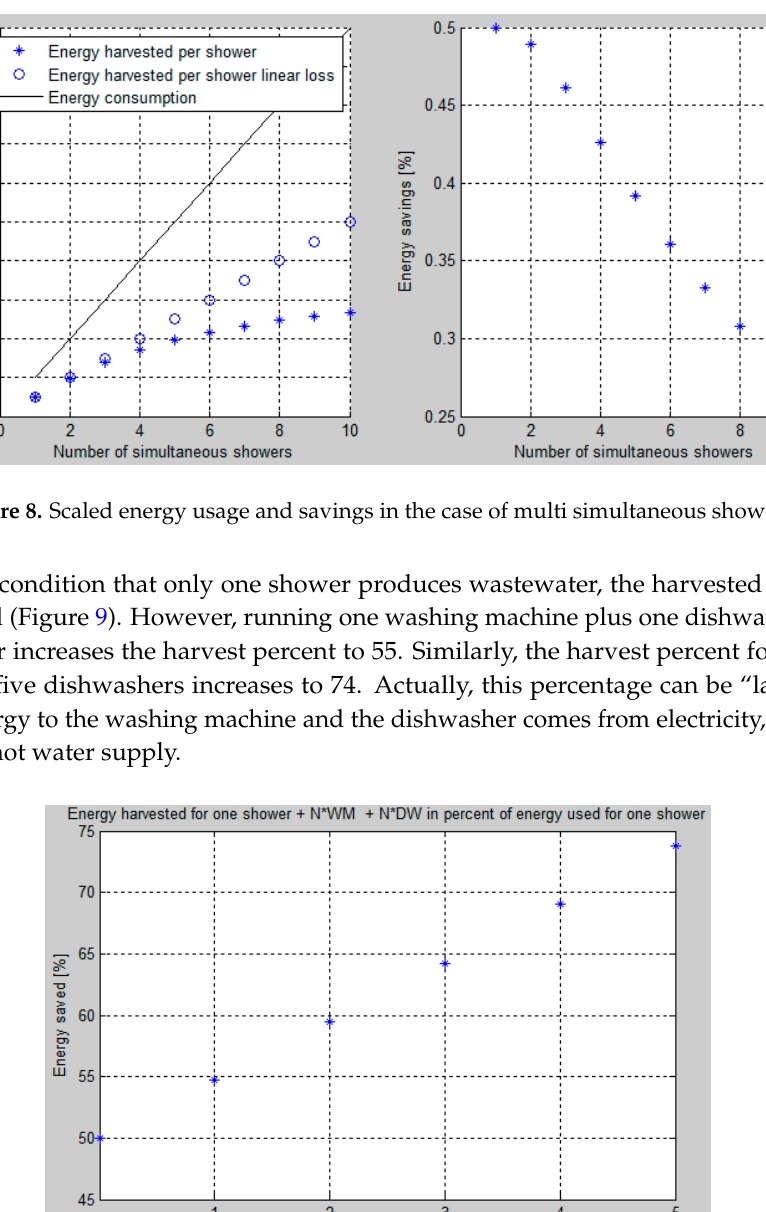
Figure 9. Energy harvested for one shower and N × (one washing machine + one dishwasher) in percentage of the energy used for one shower. Where N is the number of “one Dishwasher (DW) and one Washing machine (WM)” that run at the same time as one shower.